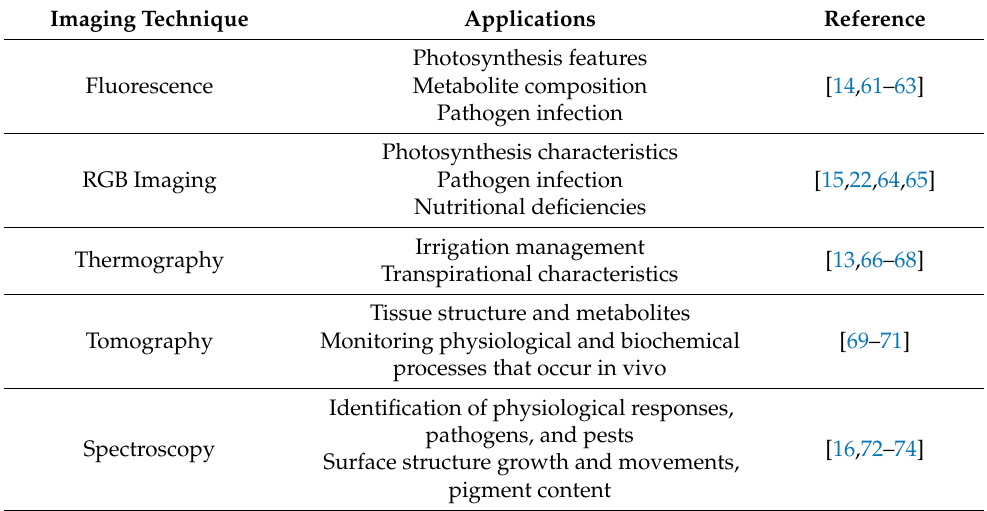
Table 3. Visualization techniques and applications [60].